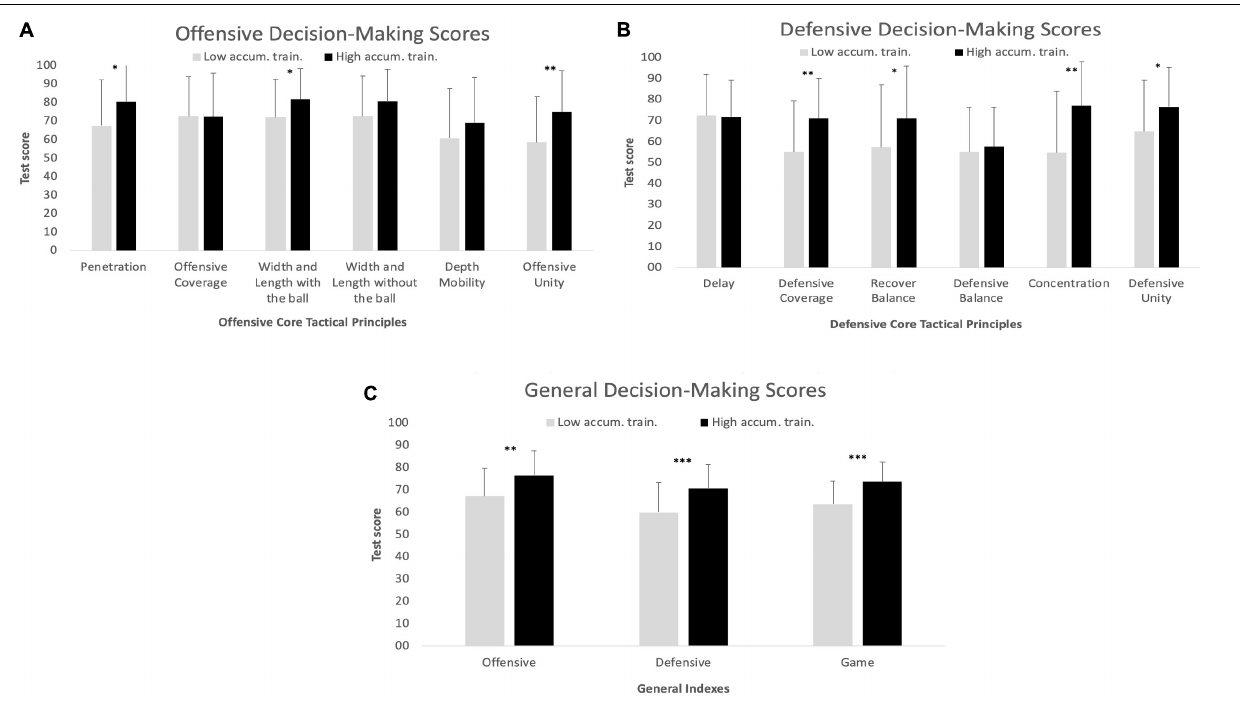
FIGURE 3 | Comparison of test scores between groups with low accumulated training hours and high accumulated training hours in (A) Offensive Decision-Making Scores, (B) Defensive Decision-Making Scores, and (C) General Decision-Making Scores. * p < 0.05, ** p < 0.01, *** p <